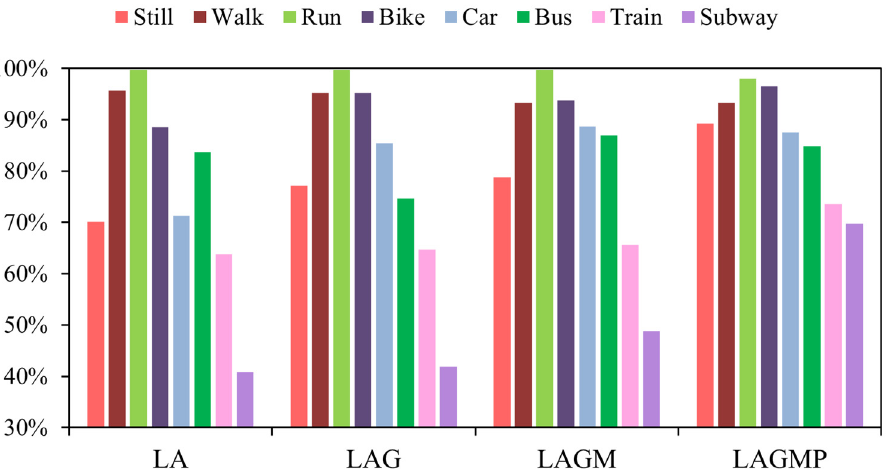
Figure 13. The precisions of T2Trans using different sensors on the SHL dataset. Note that LA is short for linear accelerometer, LAG is short for linear accelerometer + gyroscope, LAGM is short for linear accelerometer + gyroscope + magnetometer, and LAGMP is short for linear accelerometer + gyroscope + magnetometer + barometric pressure.